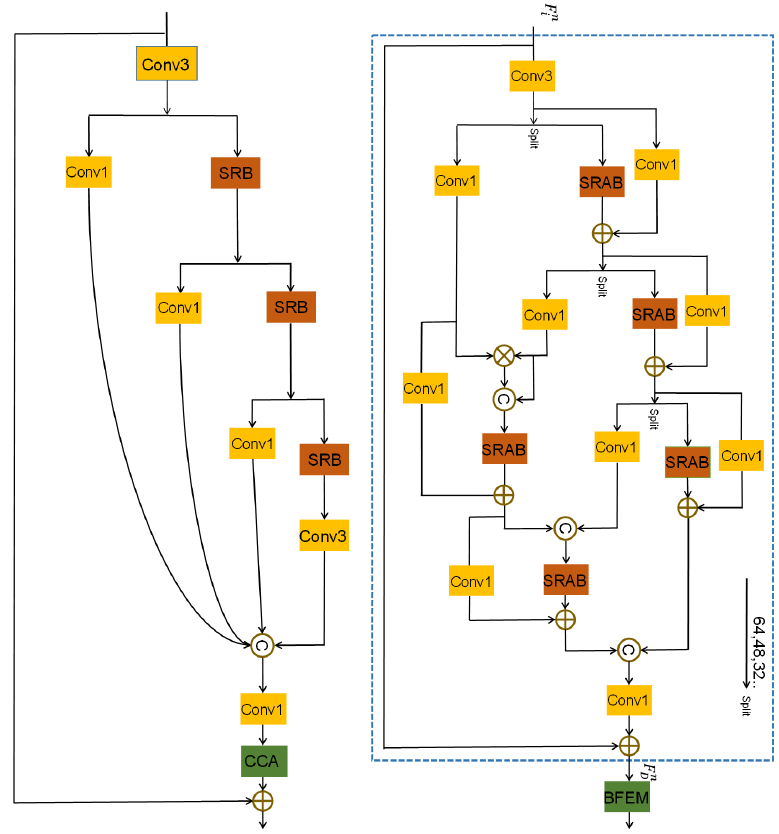
Figure 2. Comparison between the RFDB and the FDEB. ( Left ), the structure of RFDB. ( Right ), the structure of our FDEB. © represents the feature fusion; and represent the element-wise ⊕ ⊗ summation and the element-wise summation multiplication, respectively. The green and brown boxes represent the basic feature-extraction unit and the feature-enhancement block, respectively.